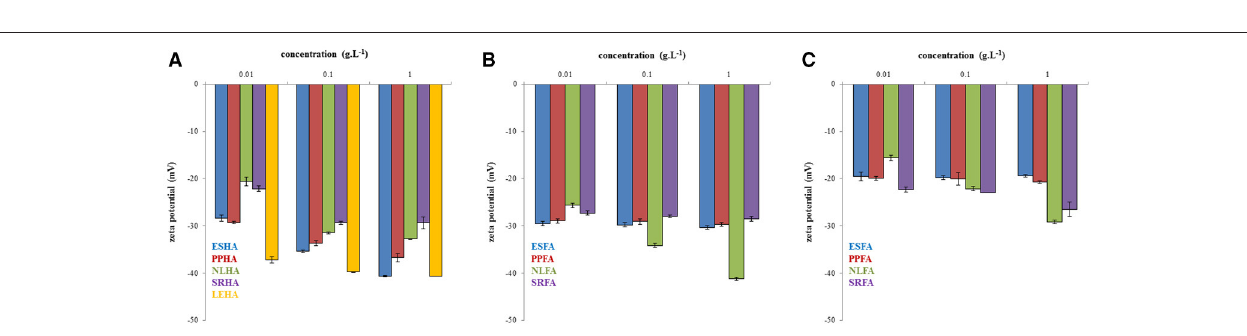
FIGURE 5 | Zeta potential of humic acids dissolved in 0.01M NaOH (A) , fulvic acids dissolved in 0.01M NaOH (B) and fulvic acids dissolved in water (C)